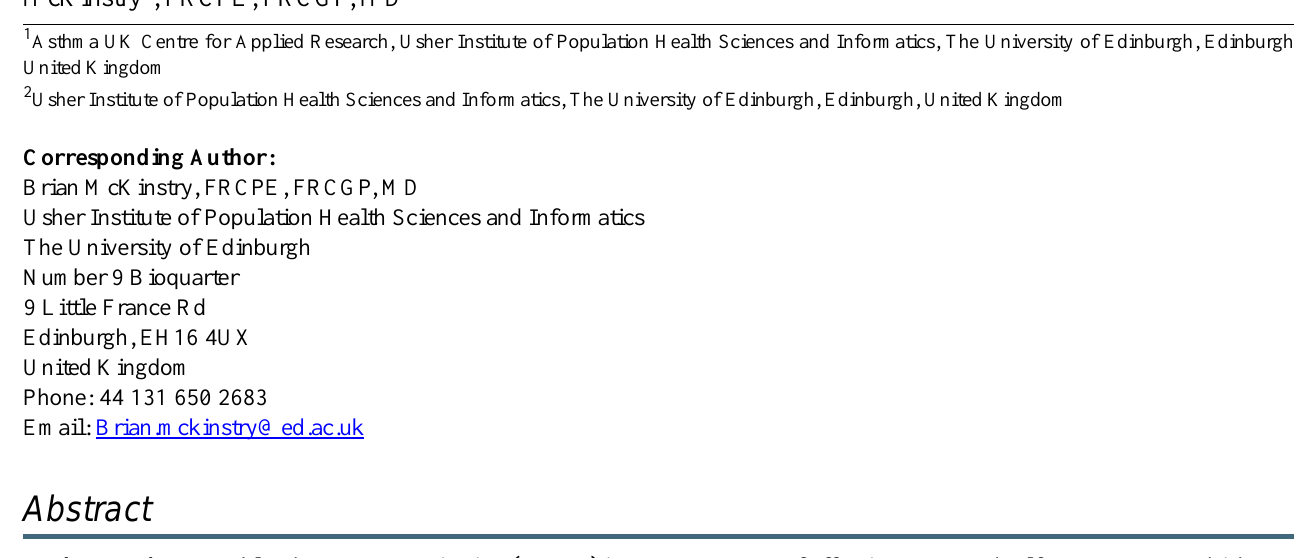
hypertension; self-management; telehealth; telemedicine; mobile